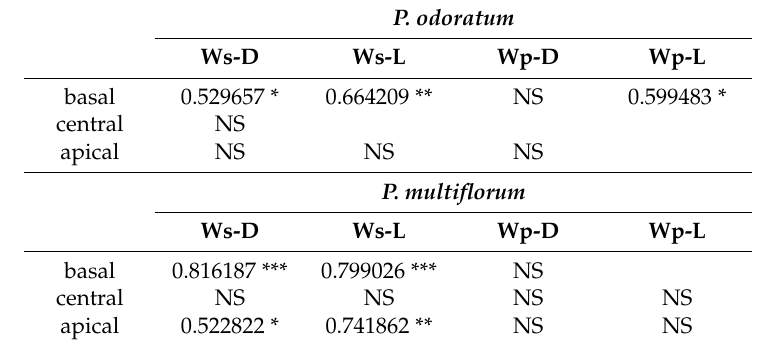
Table 4. Values of Pearson’s correlation coefficients ( r ) between the thickness of the sclerenchyma zone (Ws) and the thickness of the outer parenchyma cylinder (Wp) vs. shoot diameter (D) and shoot length (L) for P. odoratum and P. multiflorum based on three regions of the shoot (basal, central and apical). P. odoratum